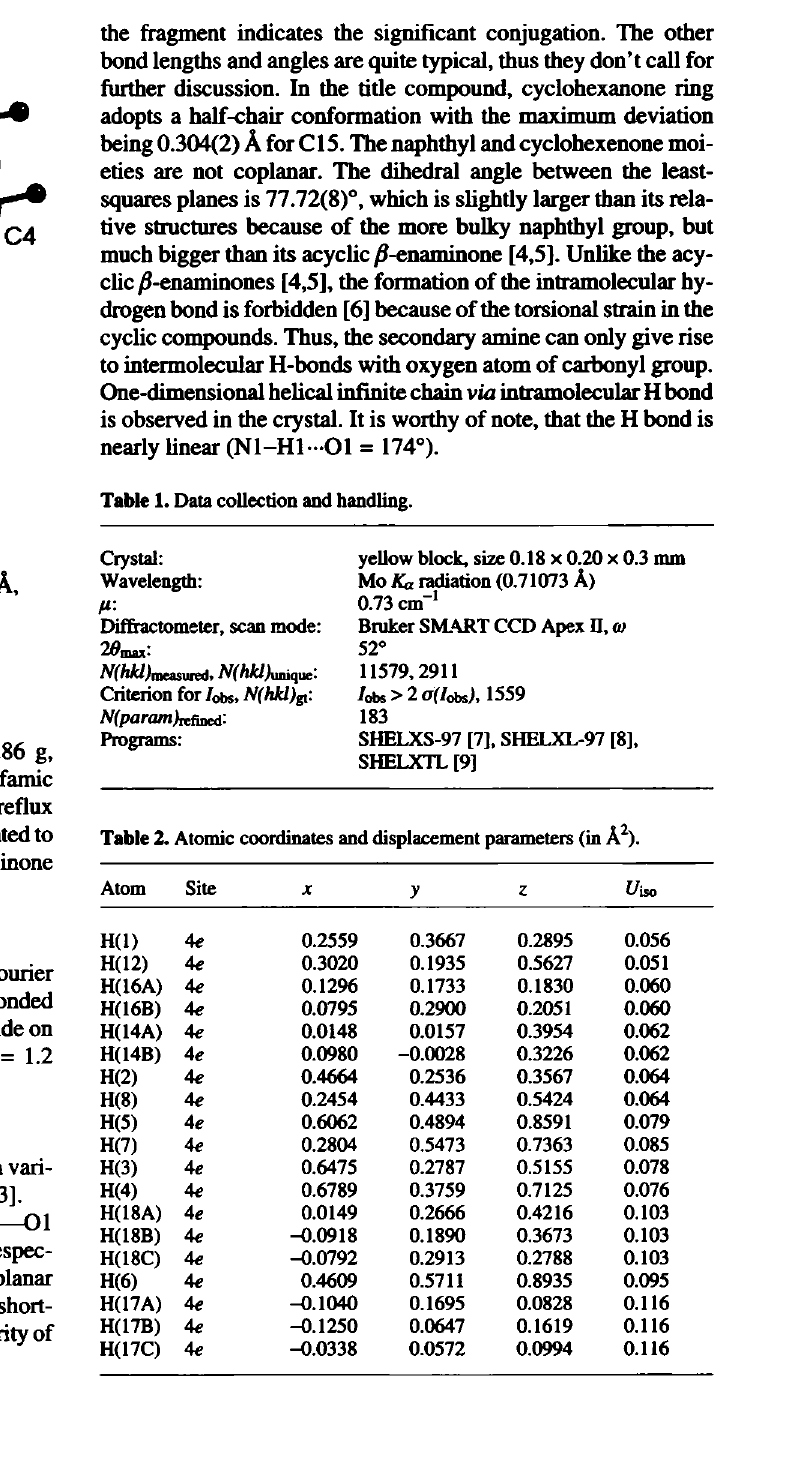
Table 2. Atomic coordinates and displacement parameters (in Â 2